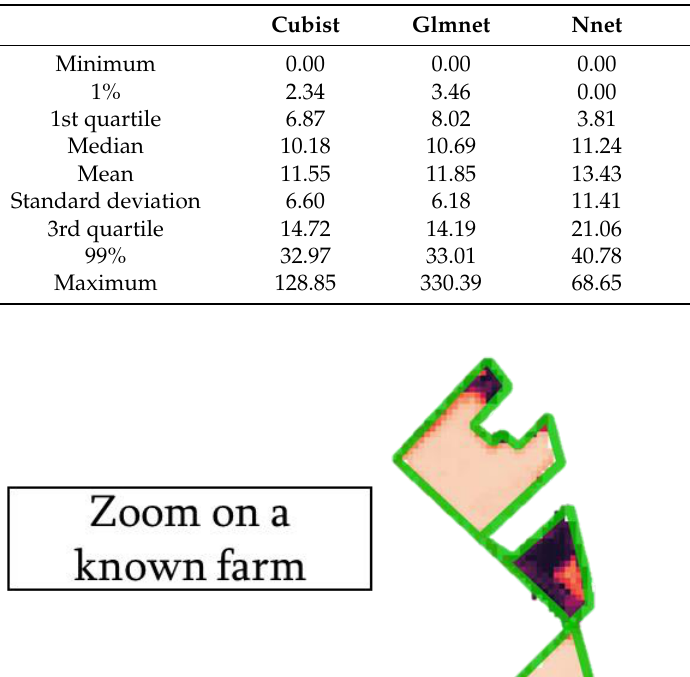
Table 7. Descriptive statistics of the coefficient of variation of the CSH computed for each date for each parcel.